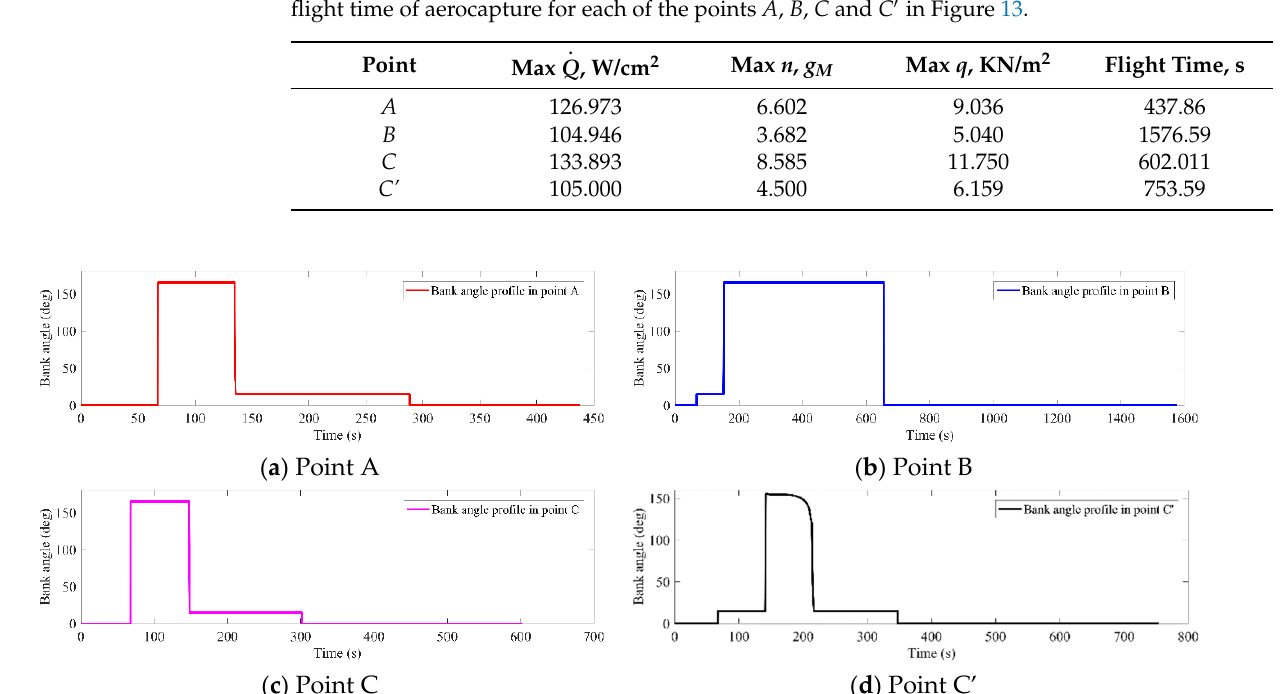
Figure 14. Bank angle profiles for each of the points A , B , C , and C ′ in Figure 13.